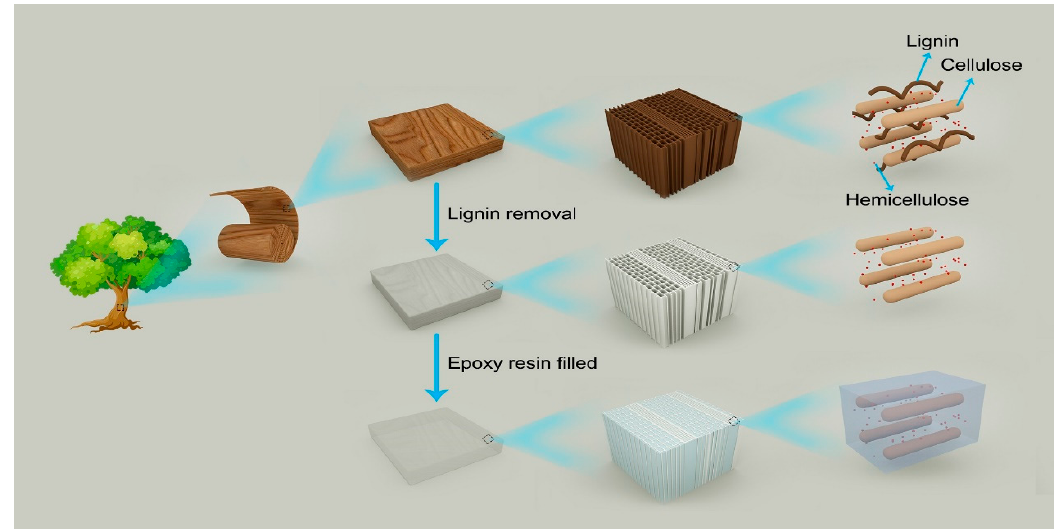
Figure 1. Schematic diagram of TPVs prepared from PV.